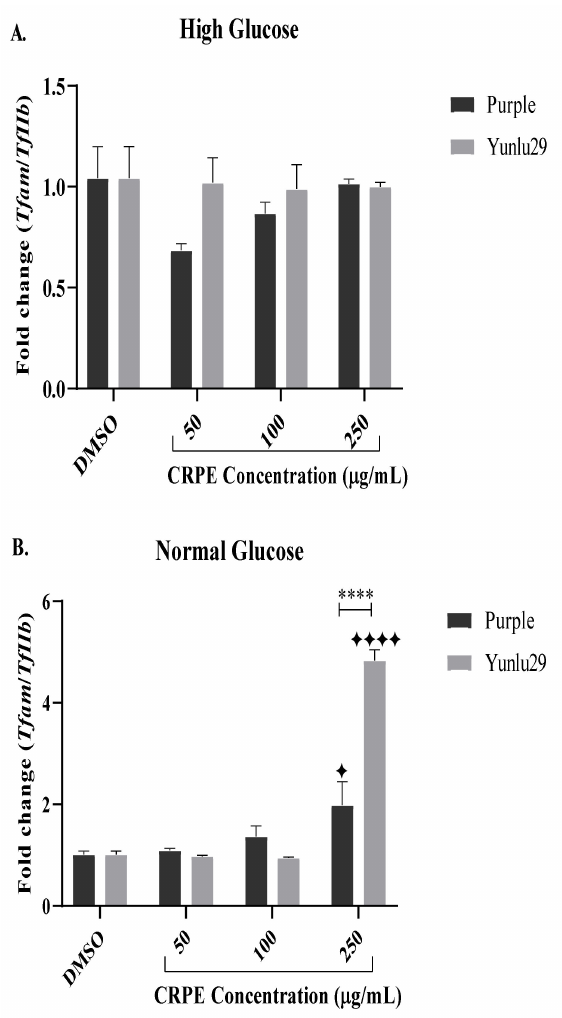
Figure 4. Expression of Tfam in INS-1E cells. A ) high glucose (25 mM). B ) normal glucose (11.1 mM). n = 3. Stars indicate significant di ff erences between extracts and DMSO, where (cid:70) p < 0.05, (cid:70)(cid:70)(cid:70)(cid:70) p < 0.0001. Asterisks indicate significant di ff erences between the extracts, where **** p < 0.0001; two-way ANOVA with Turkey’s multiple comparison post hoc test. Data is presented as mean ±